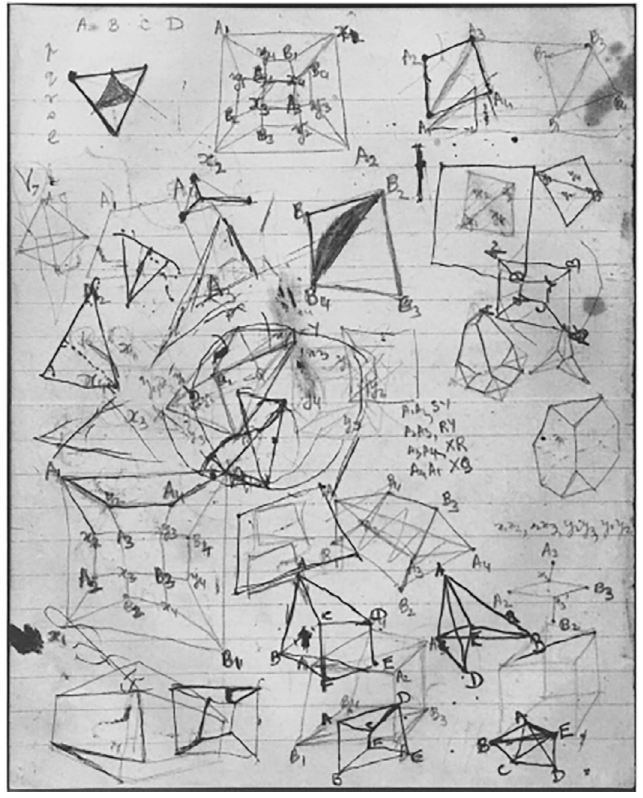
Fig. 4 P.A.M. Dirac, Geometrical Sketches, in Galison,